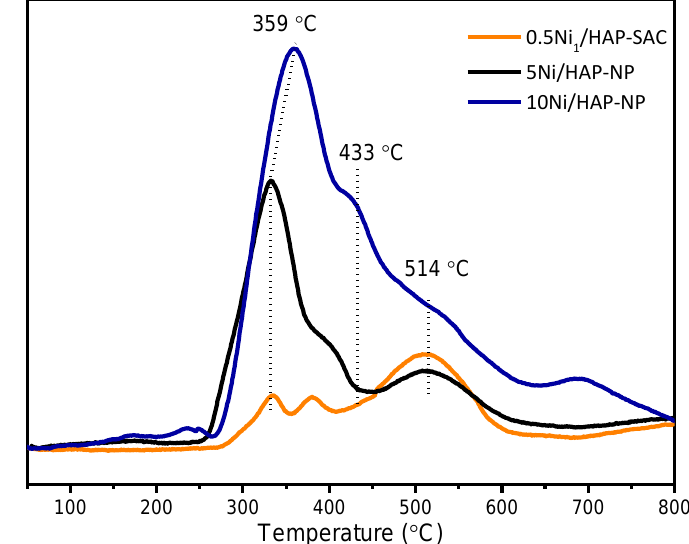
Figure 3. TPR-H 2 diagrams of x%Ni/HAP catalysts with different nickel loading amount (x = 0.5; 5; and 10 wt.% Ni).